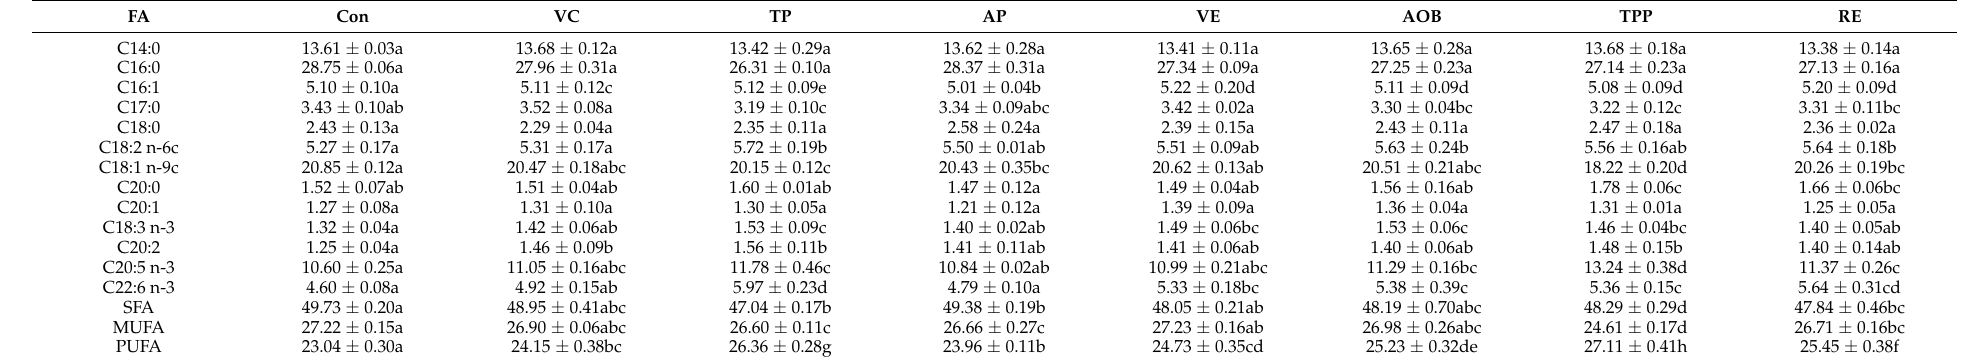
Table 1. The FA composition (relative content, %) of krill oils added with different single antioxidants during the extraction process.